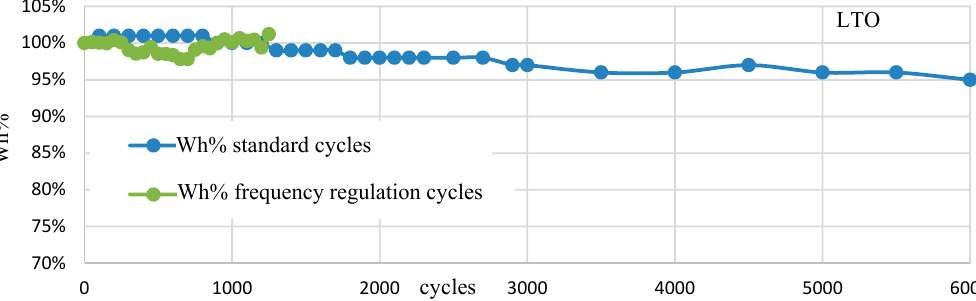
Figure 12. NaNiCl2 (M2) technology: comparison between the expected ageing, declared in the tender phase, and the ageing after the standard and frequency regulation cycles. Figure 13 NaNiCl 2 (M1) technology: comparison between the expected ageing, declared in the tender phase, and the ageing after the standard and frequency regulation cycles. As it is possible to see in Figures 7–13, the number of cycles widely varies for each technology. This fact is due to the nominal discharge/discharge time changes between the various battery technologies. Hence, the number of cycles significantly variates for the same test duration. Figures 14 and 15 compare the ageing of the different technologies following the standard cycle test and the frequency regulation one, respectively. For the LFP, LNMC, and NaNiCl 2 (M2) technologies, the ageing determined by the frequency regulation cycle is more pronounced with respect to the ageing, due to the standard cycle and to the expected ageing declared by the battery manufacturer as well. The slight increase of the battery capacity during the tests is chiefly due to the fact that the battery S.o.C. is calculated by the battery management system (BMS), starting from the integral of the charge/discharge current and by subsequently comparing the current integral with the battery capacity. Each BMS needs to be periodically re-calibrated in order to correct the current integration errors, but during the tests, no BMS re-calibration has been performed, except in case of the anomalous behaviour of the batteries. In particular, the NaNiCl 2 (M2) battery showed a sudden